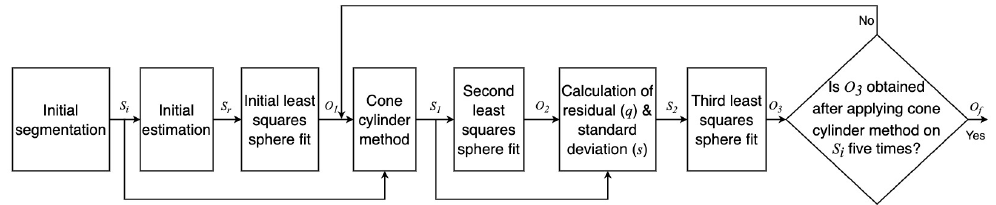
Figure 12. Procedure to calculate sphere-derived point